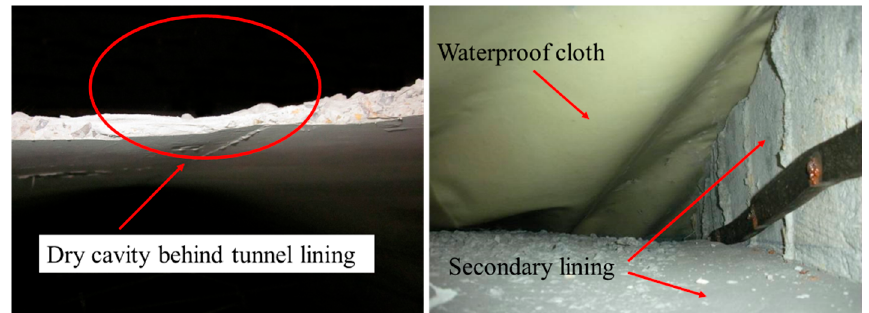
Figure 1. Cavity phenomenon behind tunnel lining.